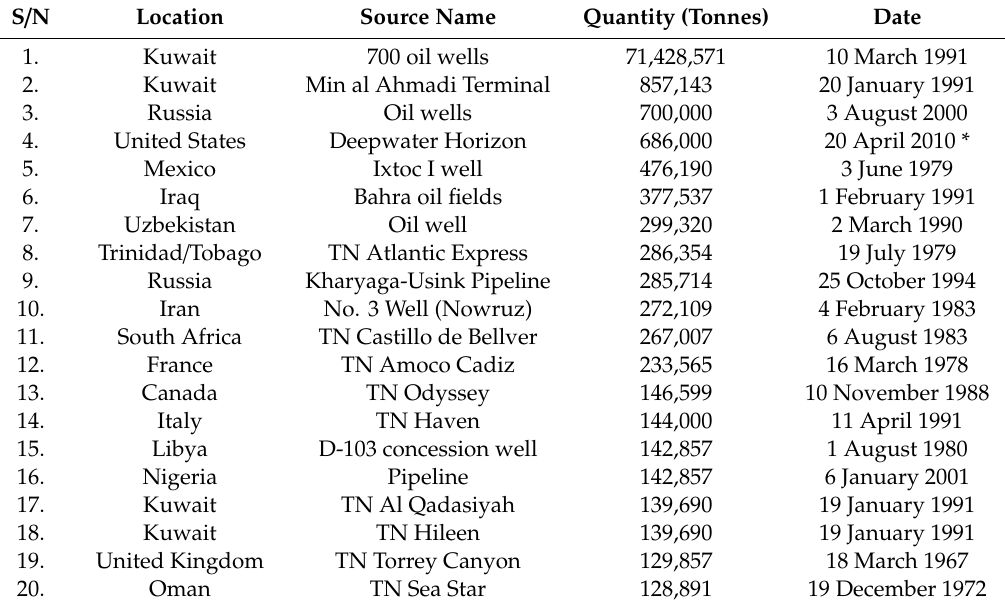
Table 1. The top 20 largest oil spills ( > 125,000 tonnes) in world’s